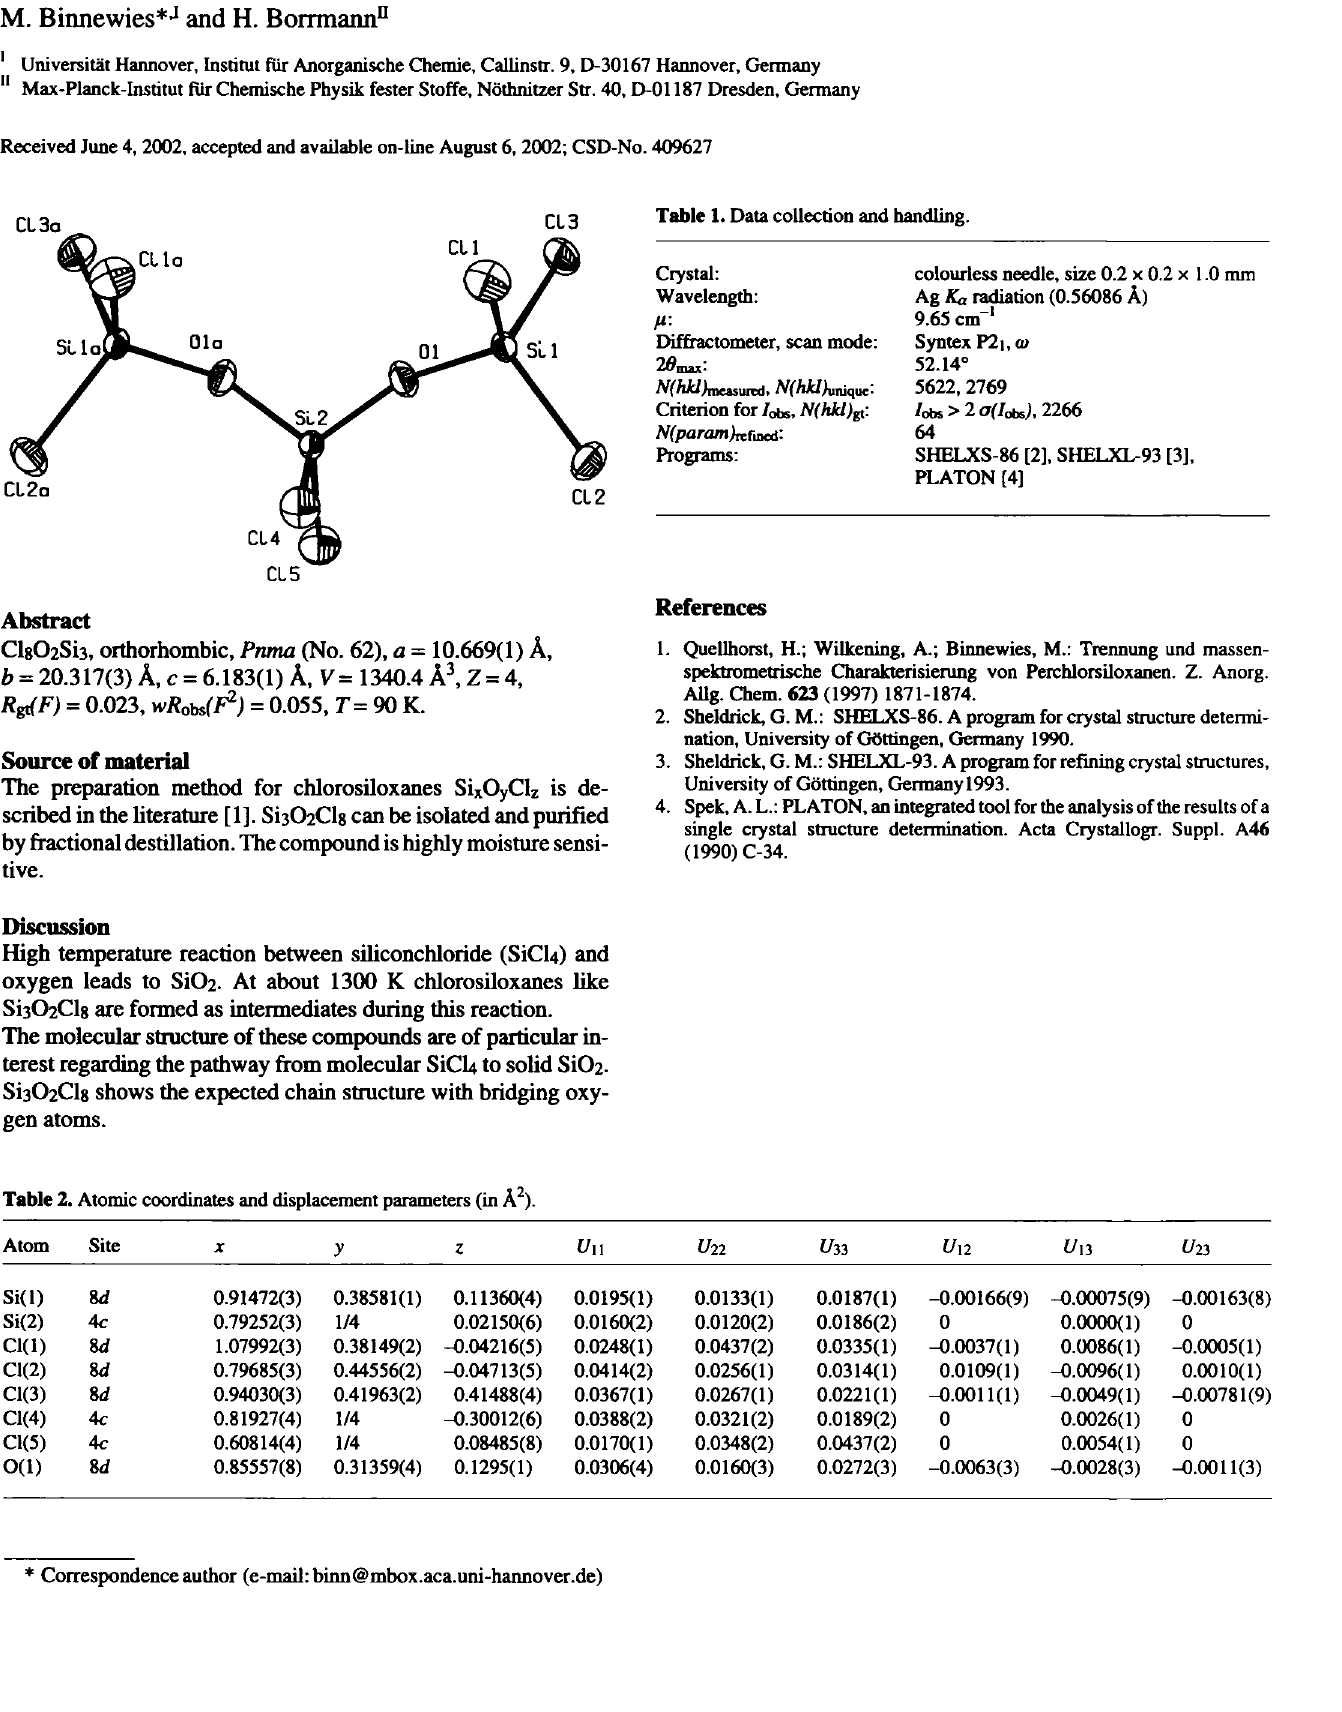
Table 1. Data collection and handling.